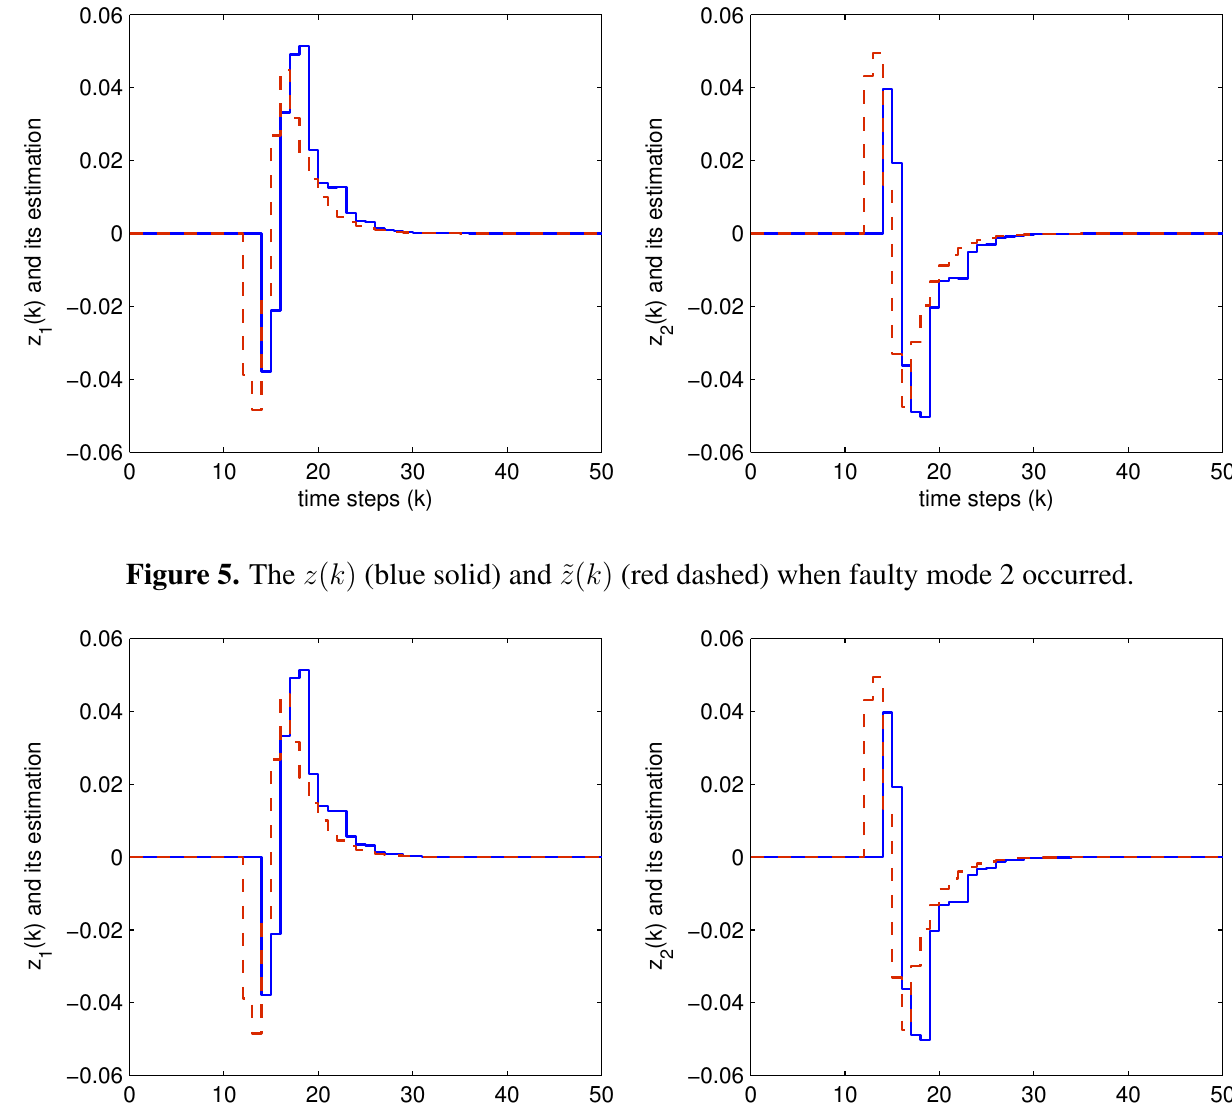
Figure 4. The z ( k ) (blue solid) and ˜ z ( k ) (red dashed) when faulty mode 1 occurred.